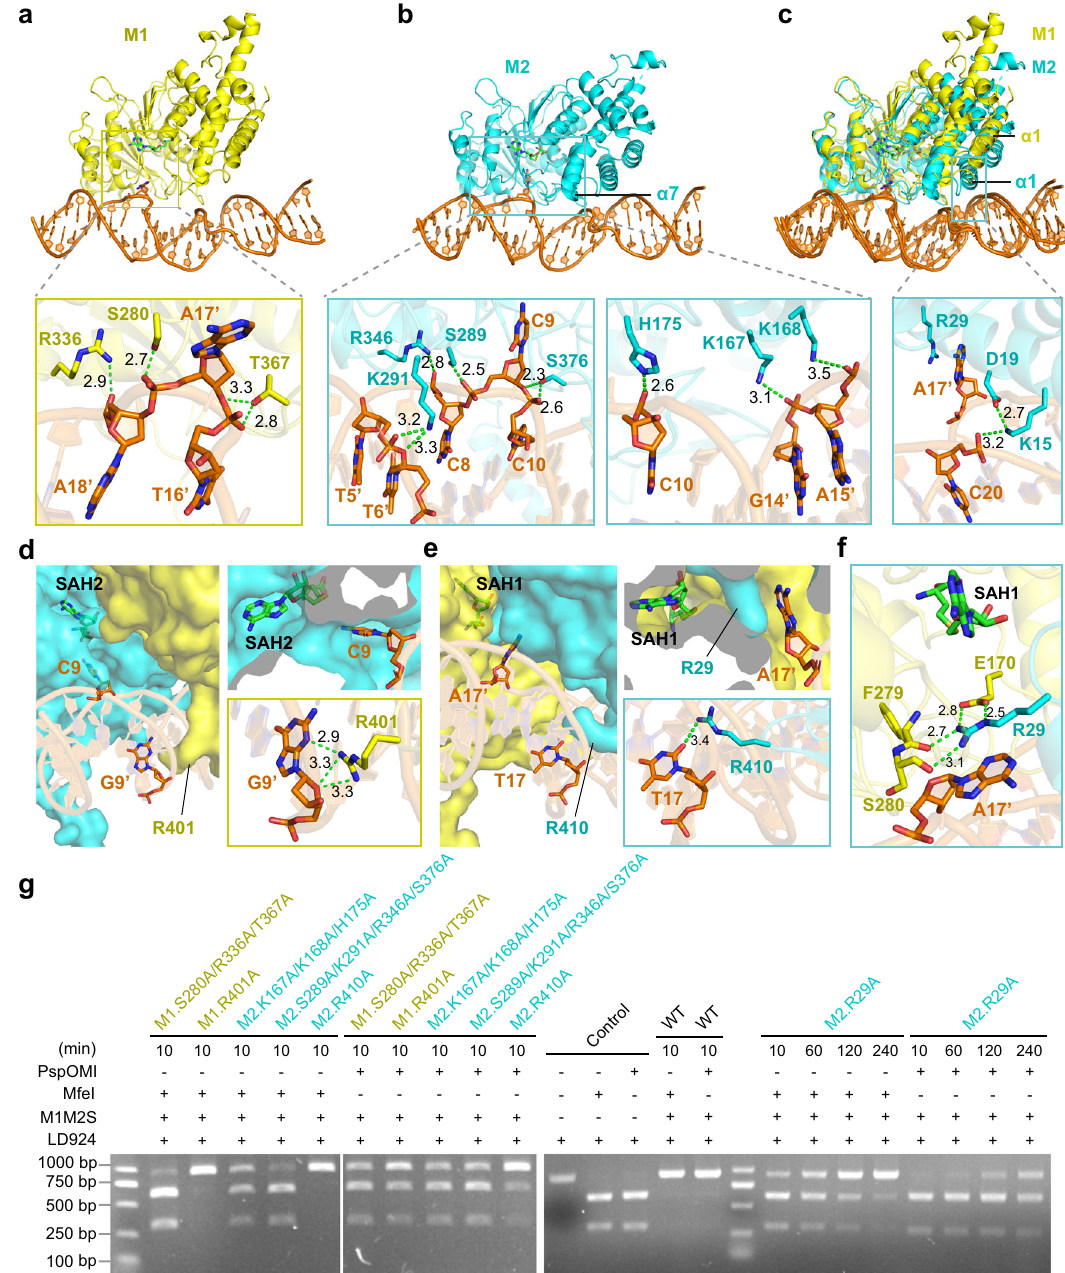
Fig.4|DetailedinteractionsbetweenDNAandM1/M2subunitsofPacIIMTase. a, b Overall structures and detailed interactions of M1-DNA interface ( a ) and M2- DNA interface ( b ). Green dashed lines indicate hydrogen bonds. c Structural superimposition of M1-DNA and M2-DNA by using DNA as reference, and the helix α 1 of M2 insert into the major groove of DNA to mediate contacts. Green dashed lines indicate hydrogen bonds. d Surface view of M1/M2 bound to DNA motif (5'- CCC-3'), target cytosine (C9) inserts into the catalytic pocket of M2, and residue R401 of M1 contacts with the paired guanine (G9'). Green dashed lines indicate